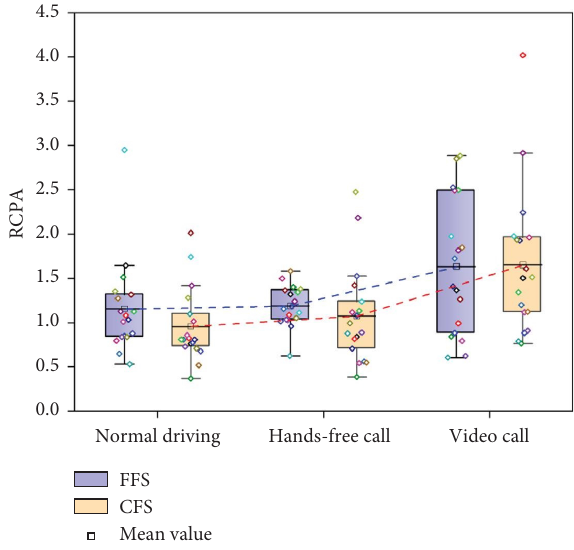
Figure 8: Comparison of drivers’ RCPA for each driving state in diferent trafc